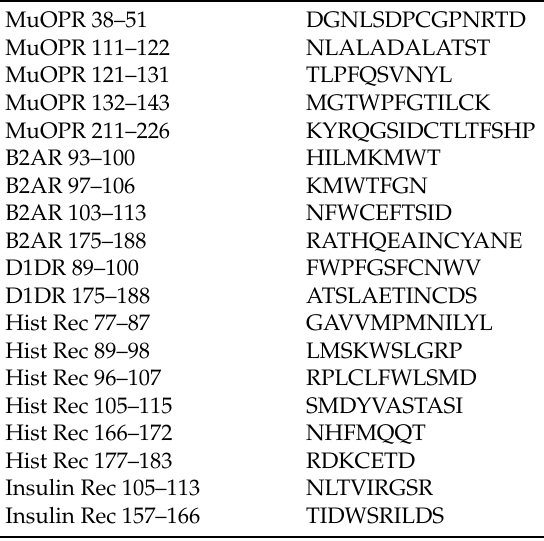
Table 1. List of peptides synthesized from extracellular and transmembrane loops of the mu opioid receptor (muOPR), β -2-adrenergic receptor (B2AR), dopamine receptor D1 (D1DR), histamine 1 receptor (Hist Rec) and insulin receptor (Insulin Rec).